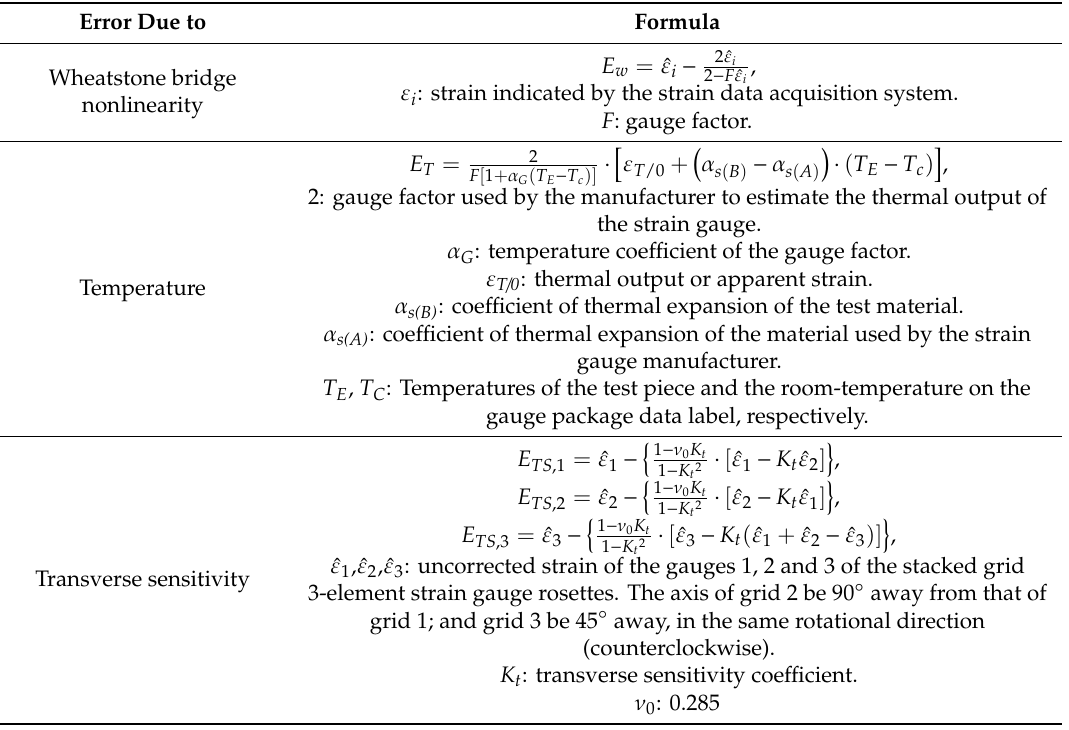
Table 2. Main error sources in strain gauges measurement technique